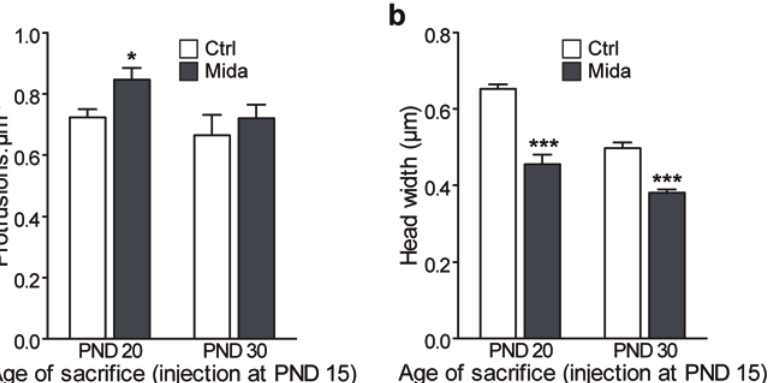
Figure 3. Effects of midazolam on protrusion density and on head width lasts for several days. ( a ) A 5 h midazolam anesthesia is performed at PND 15, protrusion density is measured at PND 20 in one group and at PND 30 in another group. ( b ) Protrusion head width at PND 20 and PND 30 compared to control groups. (b, c): n =4 animals per group, 1571 spines; ***: P , 0.001, *: P , 0.05, two-way ANOVA with Bonferroni post tests.